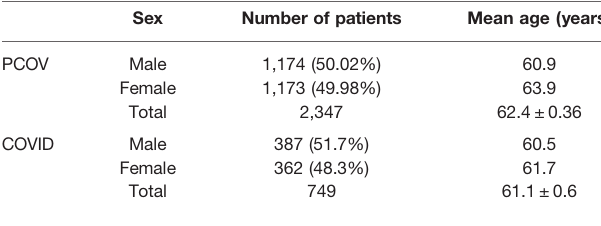
TABLE 1 | Pre-COVID and COVID cohort demographic